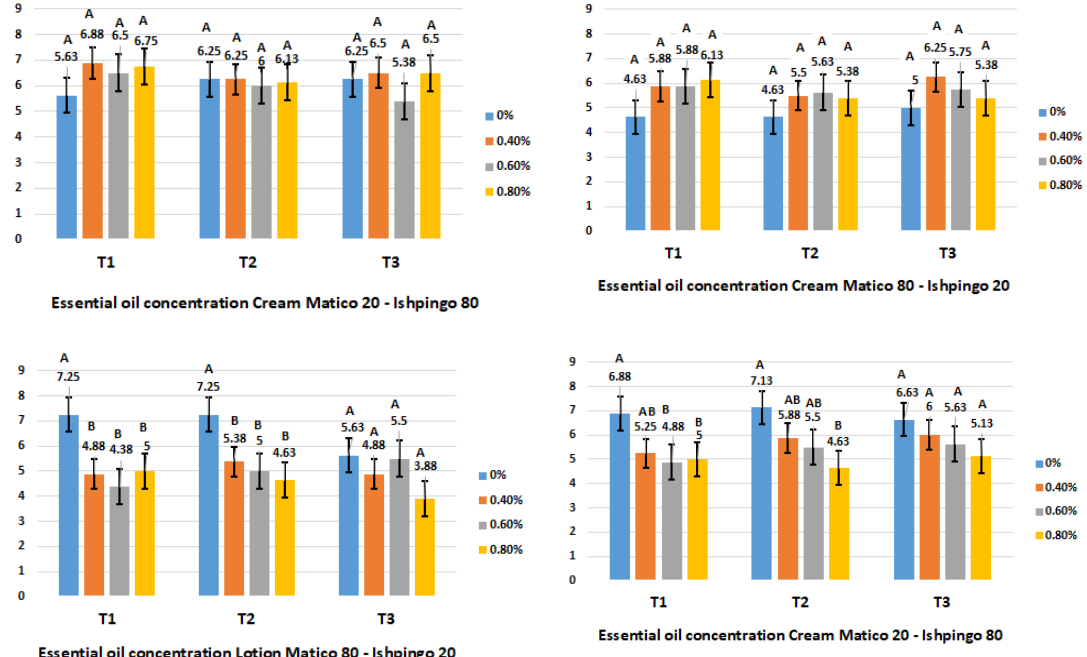
Figure 1. Adjusted means of Sensory test analysis. Note. Two treatments without a common letter are statistically significant ( p ≤ 0.05).